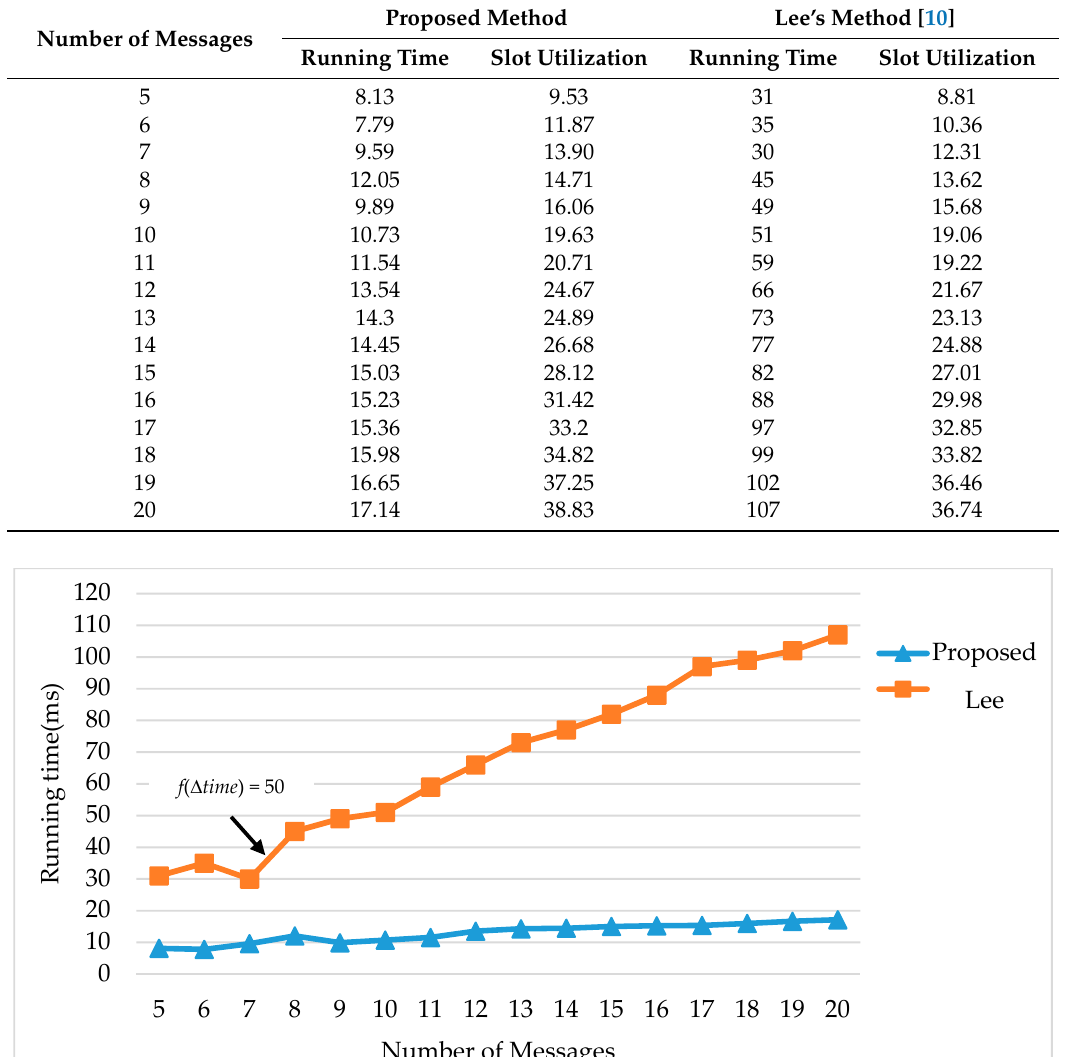
Figure 6. Comparison of running time with Lee’s method.